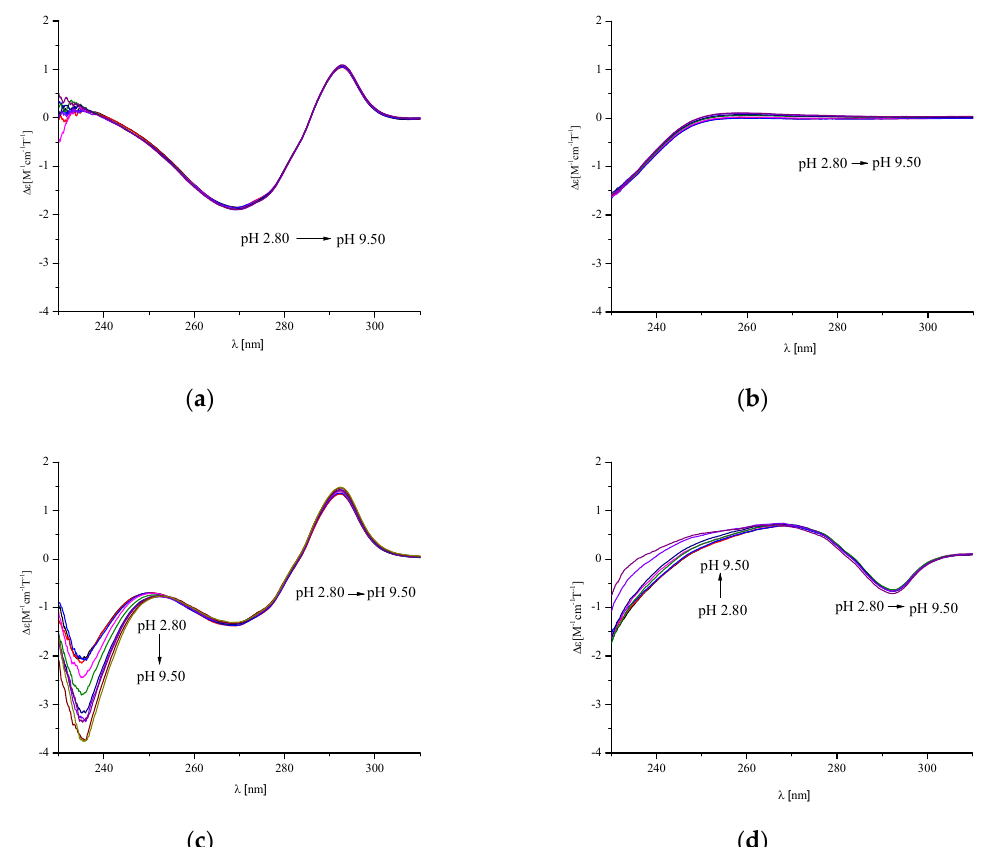
Figure 7. pH-dependent MCD spectra of: ( a ) P3: Ac-c(-S-Cys-Phe-Trp-Lys-Thr-Cys-S)-NH 2 ; ( b ) P1: Ac-c(-S-Cys-Pro-His-Lys-Lys-His-Pro-Cys-S-)-NH 2 ; ( c ) P2: c(Ser-Phe-Trp-Lys-Thr-Ser-Pro-His-Lys-Lys-His-Pro); ( d ) BCS c(c(-S-Cys-Phe-Trp-Lys-Thr-Cys-S)-Pro-His-Lys-Lys-His-Pro). The ligand concentration was 7×10 −4 mol/L and pH-metric titrations were performed in a 0.3 mol/L KCl solution. Sample volumes were 2.0 mL. The pH values were established by adding small amounts of concentrated KOH and HCl solutions.